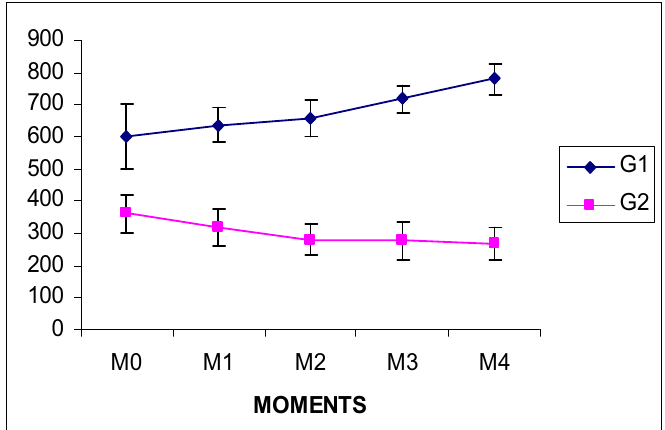
FIGURE 6 - Mean values for protein concentration (mg/100mg of tissue) of samples for the distal colon in the two groups at the experimental moments